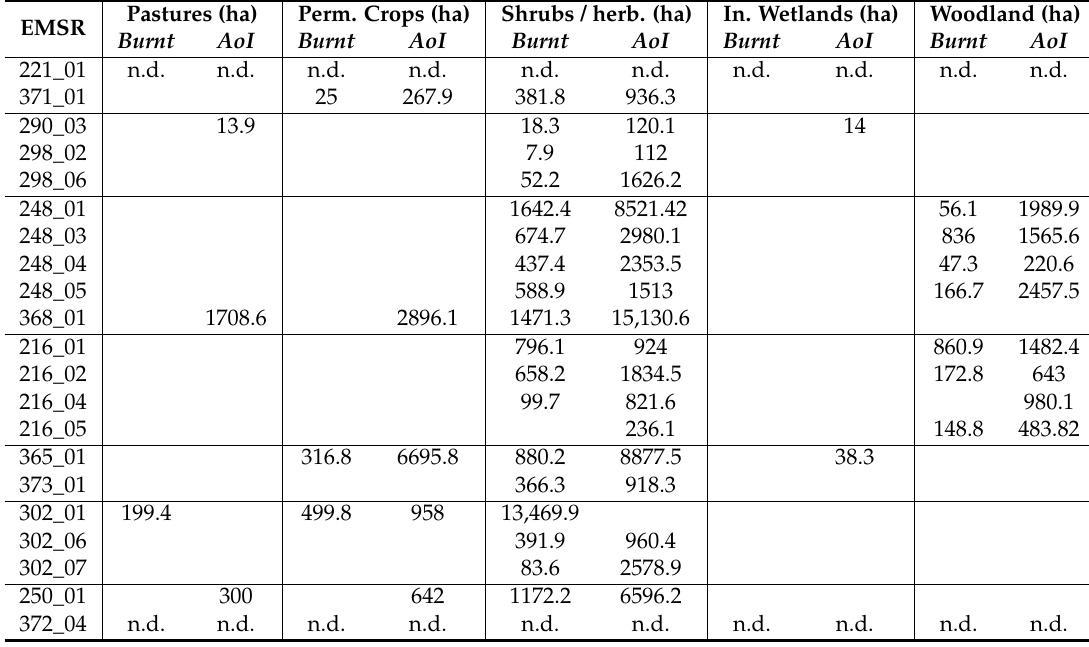
Table A3. Land use details for the AoIs considered in this work. For the sake of space, this table is partial, and continues from Table A2. It reports, in hectares: Pastures areas, Permanent crop lands, Shrubs or herbaceous vegetation areas, Inland wetlands areas, and Woodlands. For each land use type, the areas affected by fire are reported